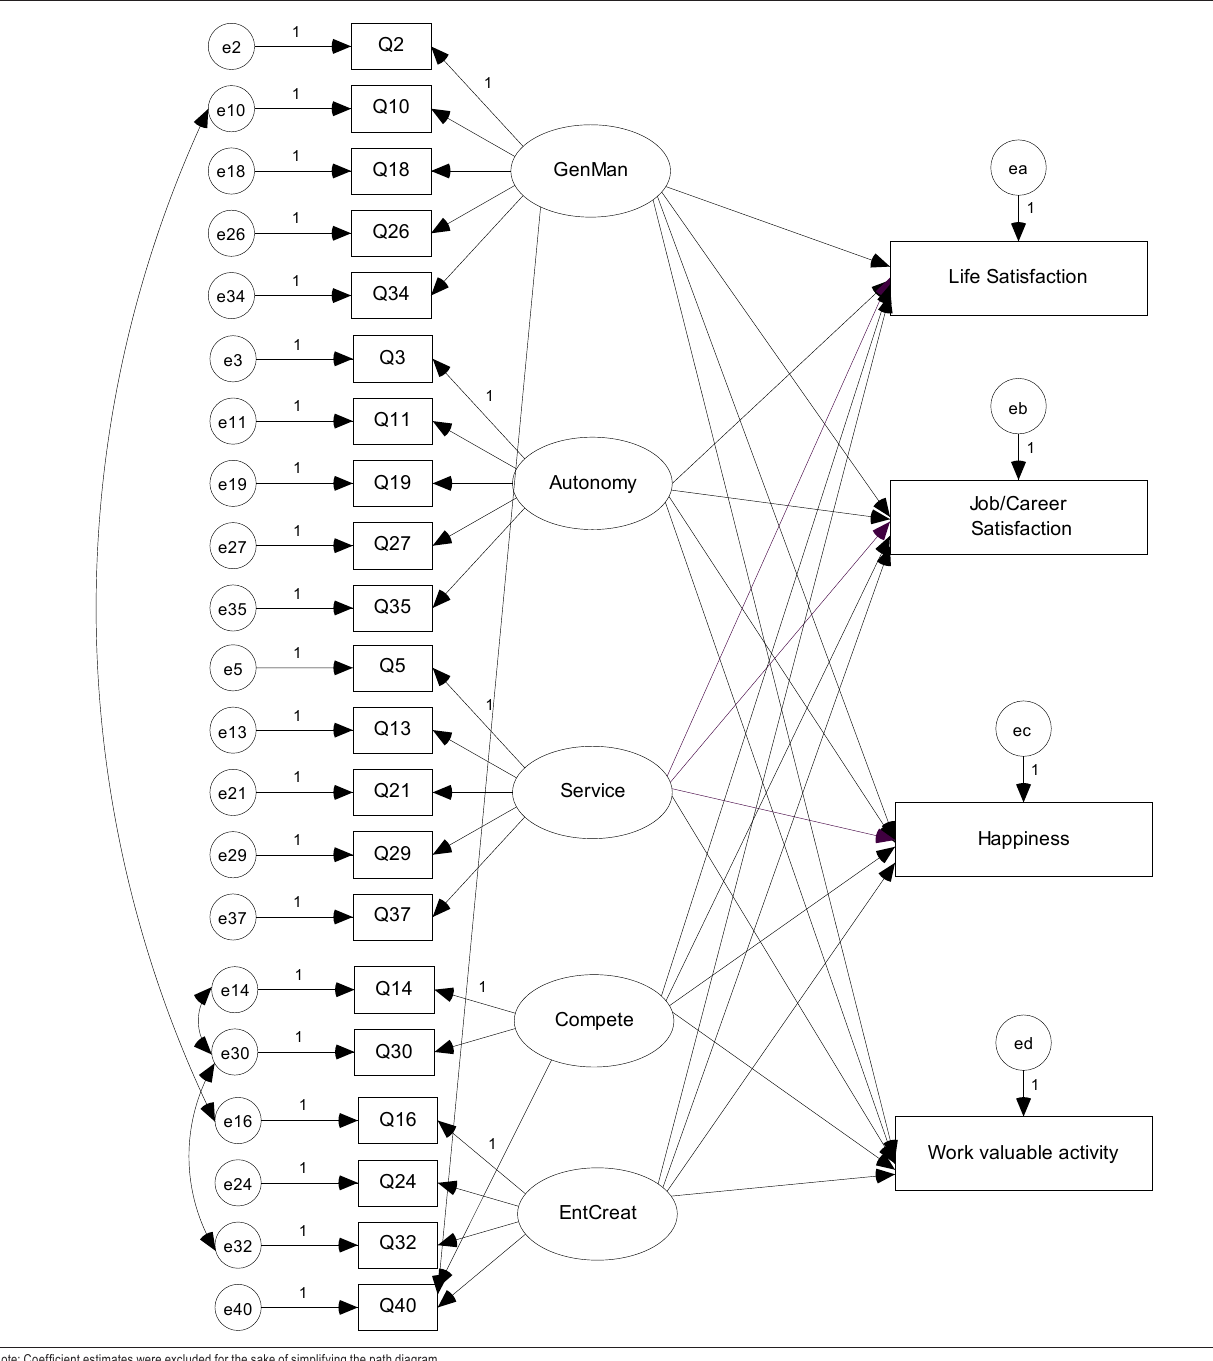
FIGURE 2 Causal model depicting the relationship between the five Career Orientations Inventory variables and four Subjective Work Experiences